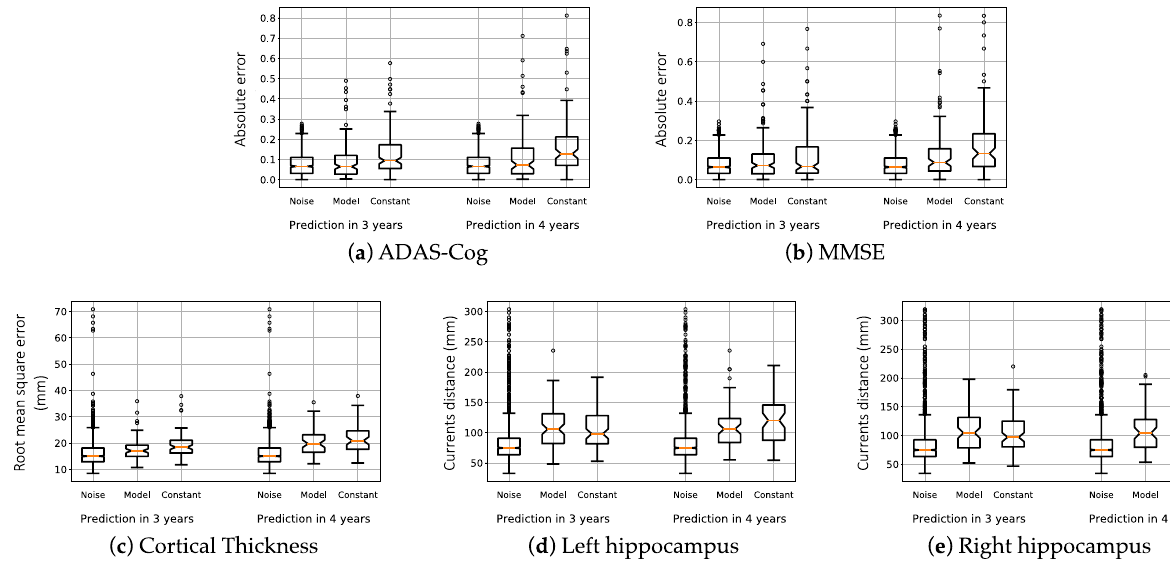
Figure 4. Prediction errors at the individual level 3 and 4 years ahead of time. Box-plots show medians in orange, quartiles, and 95% confidence intervals for three image data and the ADAS-Cog. Distributions of prediction errors are compared with that of the noise and the errors of the constant